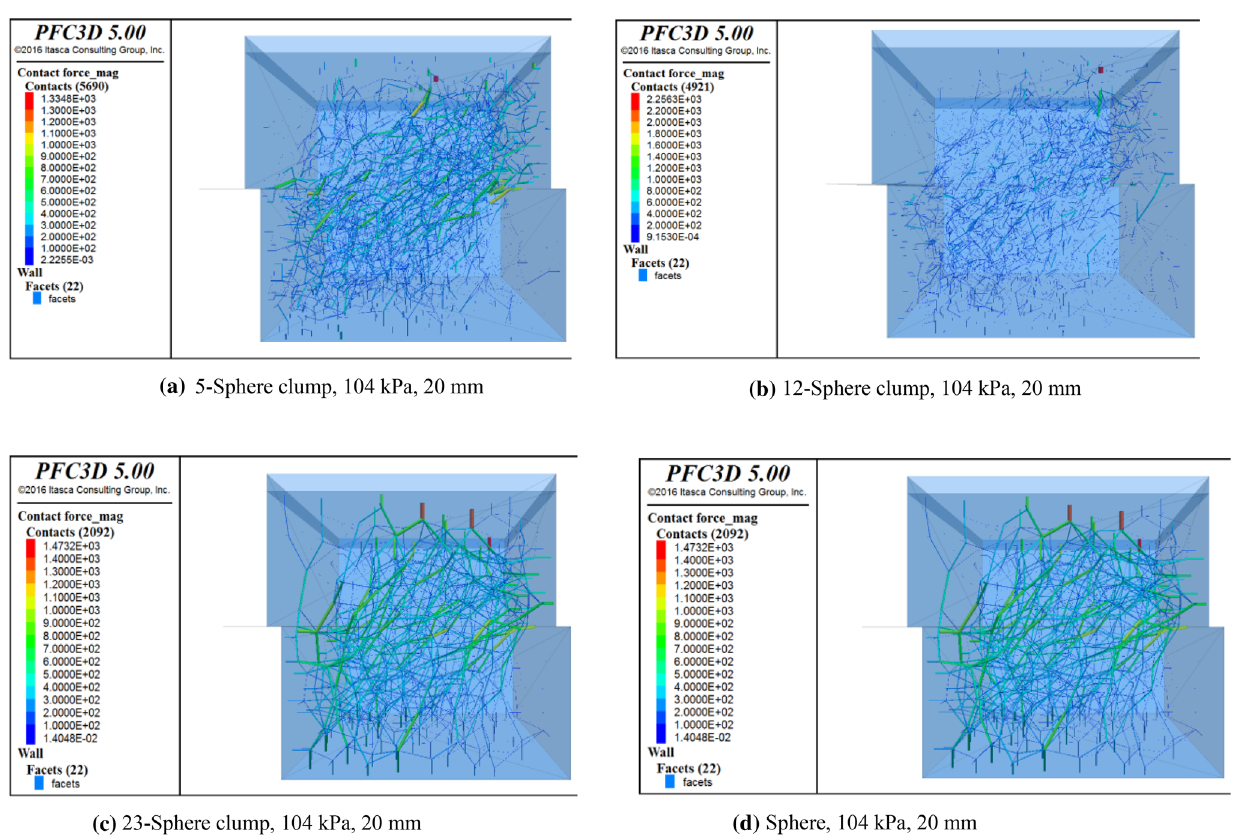
Fig. 7 Force chain results of the DST simulation under the normal stress 104 kPa and shearing displacement 20